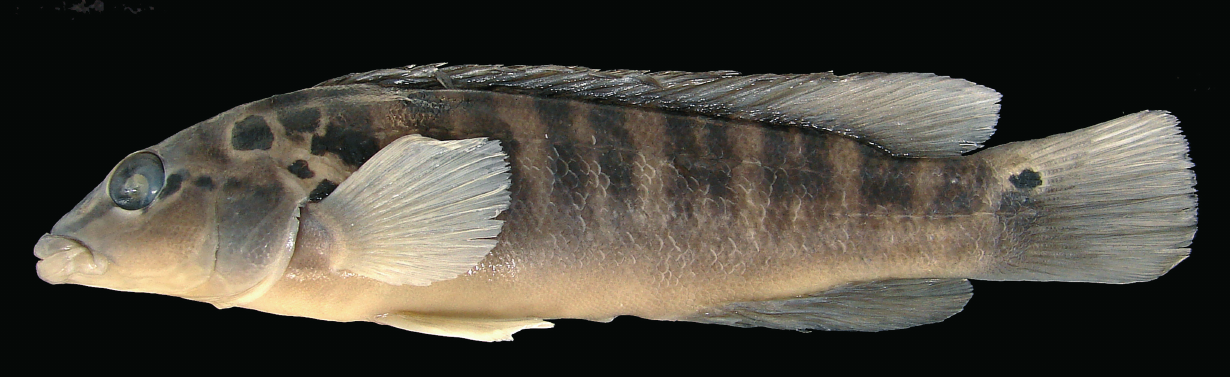
Fig. 2 . Crenicichla hadrostigma , paratype, rio Chapecó, Coronel de Freitas, Santa Catarina, MCP 40079 (100.8 mm SL,